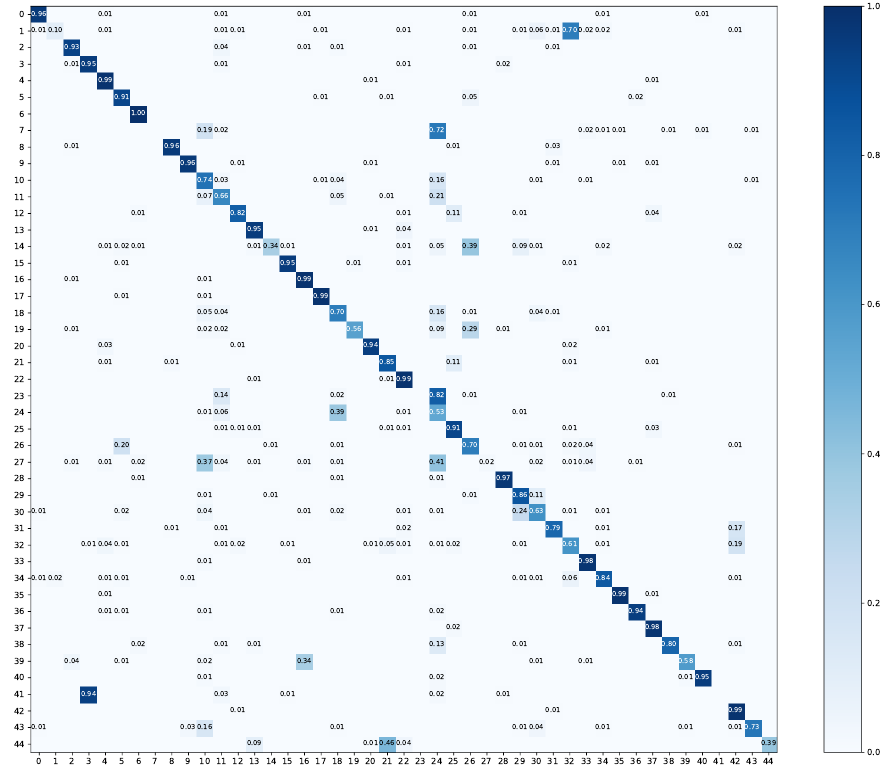
Figure 7. Confusion matrix obtained by MixMatch on NWPU-RESISC45 testing